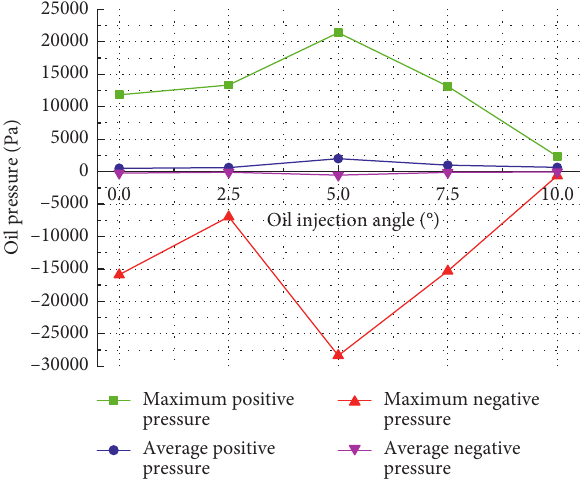
Figure 8: Oil pressure line diagram at different injection